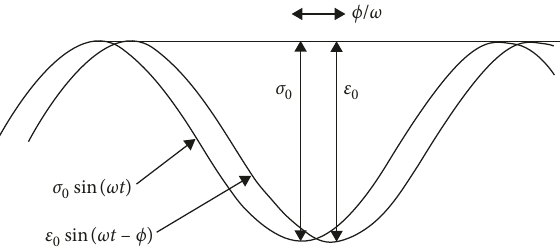
Figure 5: Schematic of the sine wave associated with the loading of the samples.